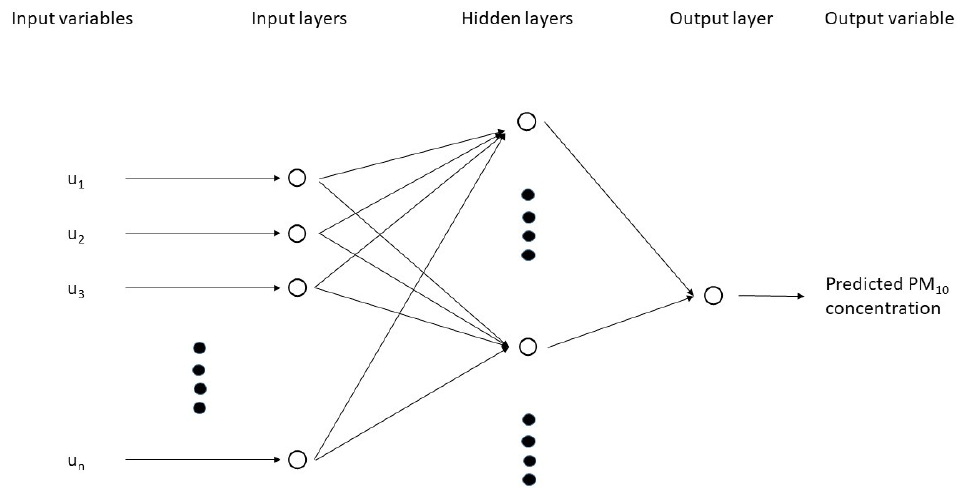
Figure 2. A schematic representation of the feed-forward neural network (FFNN).